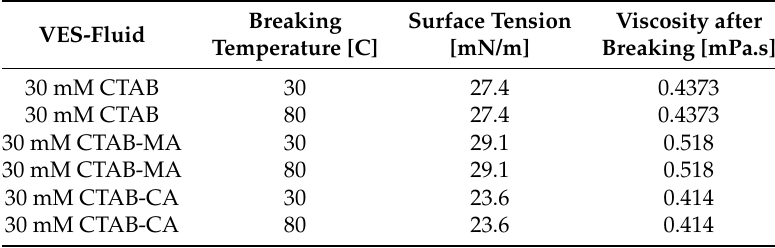
Table 3. The surface tension and interfacial tension of different VES fluids at ethanol to fluid ratio of 15:100 and different temperatures.